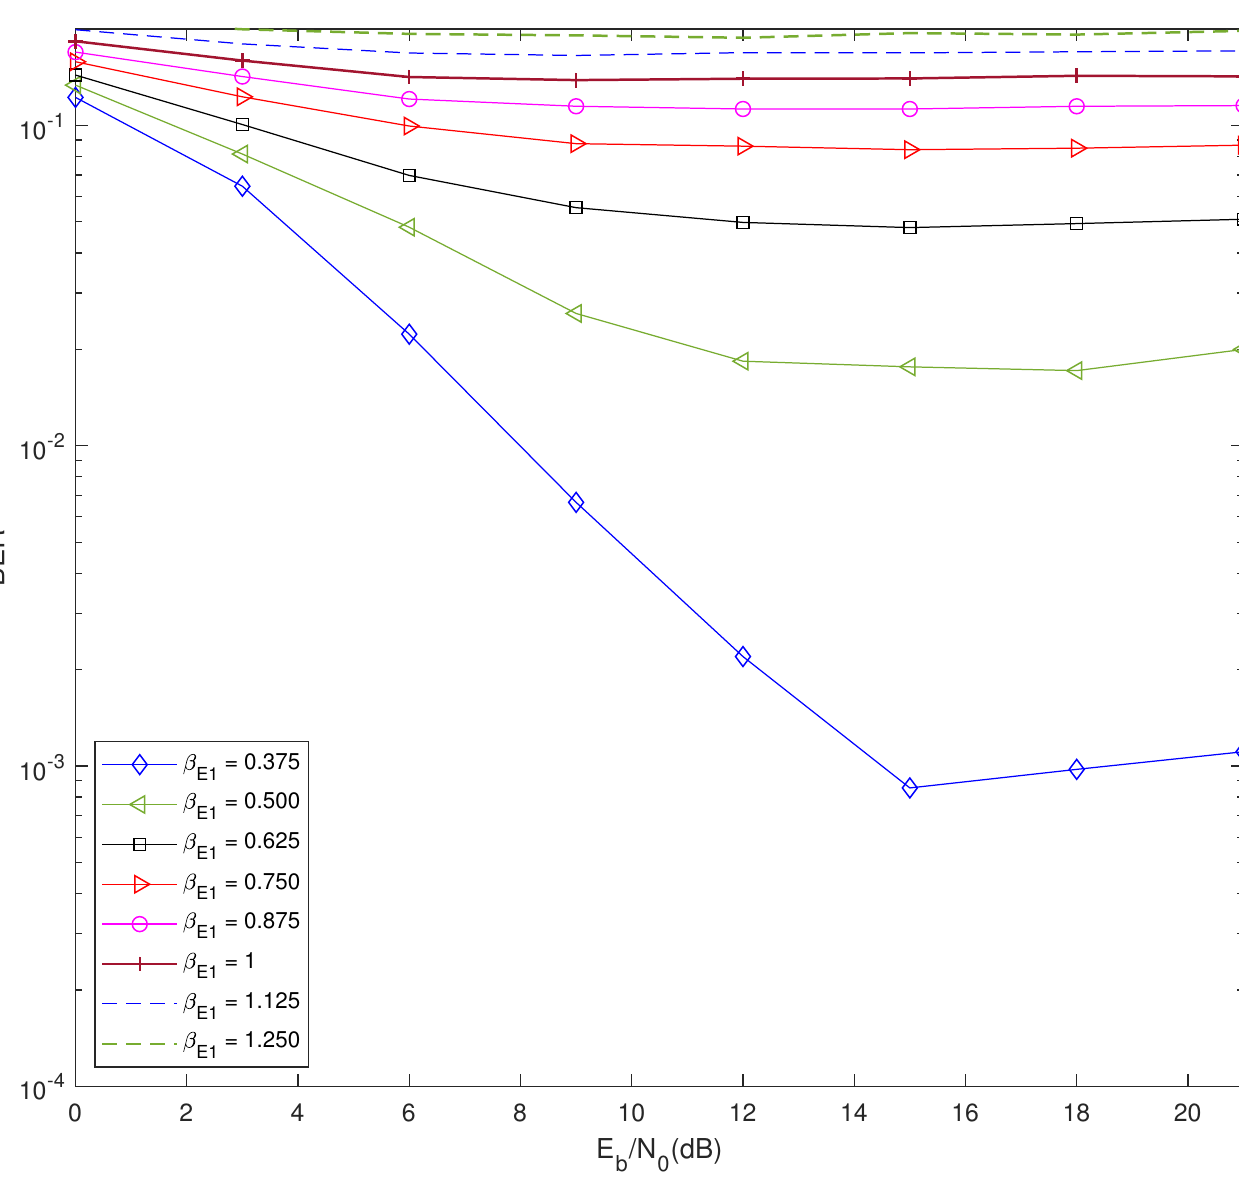
Figure 2. The BER results of E1 without the feedback of jamming signal estimate, where R E 1 = 2, T I =